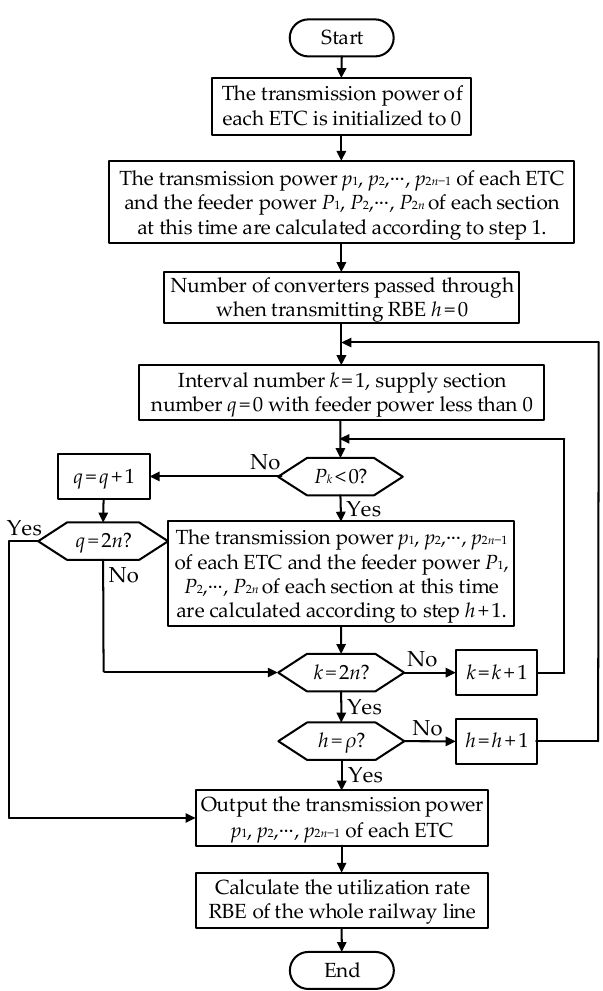
Figure 11. Flowchart of the algorithm.